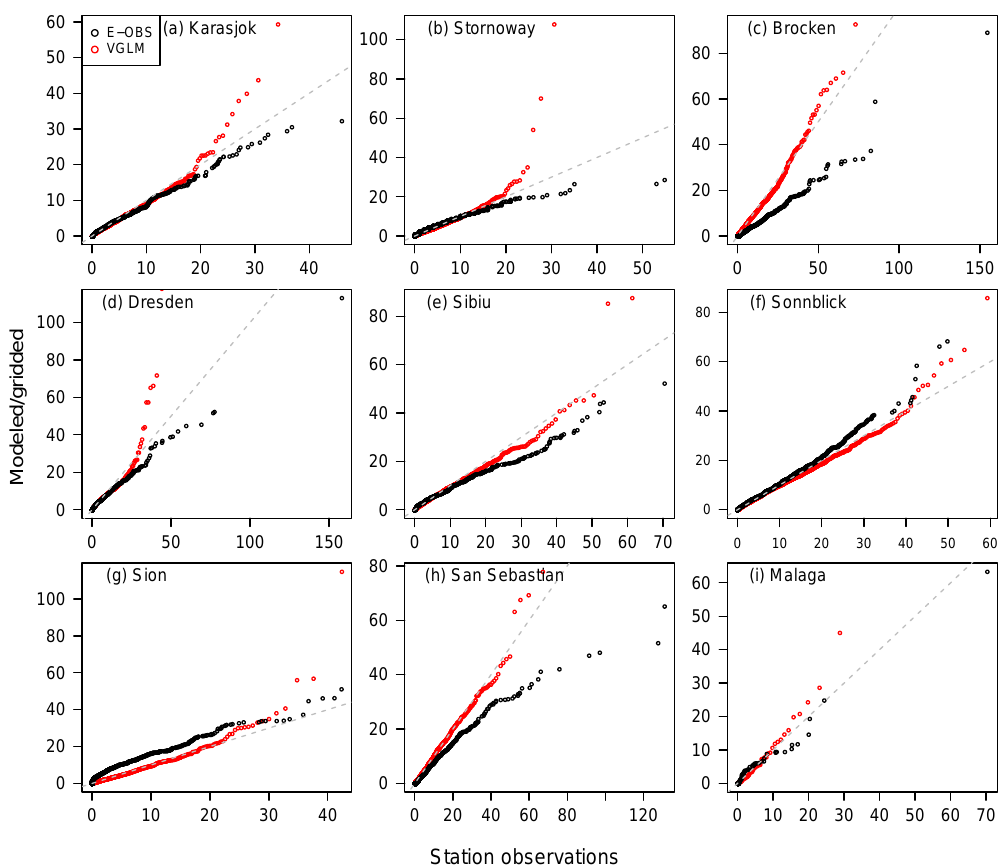
Figure B2. Step 2: downscaling. QQ plots for example stations in JJA. VGLM gamma standardized to the stationary gamma distribution fitted to observed wet day intensities between gridded and point-scale precipitation observations (mmday − 1 ). (a) Karasjok, (b) Stornoway, (c) Brocken, (d) Dresden, (e) Sibiu, (f) Sonnblick, (g) Sion, (h) San Sebastian, and (i)